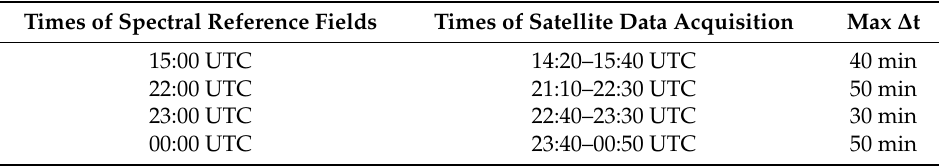
Table 1. Times of spectral reference fields and of satellite data acquisition. Times of Spectral Reference